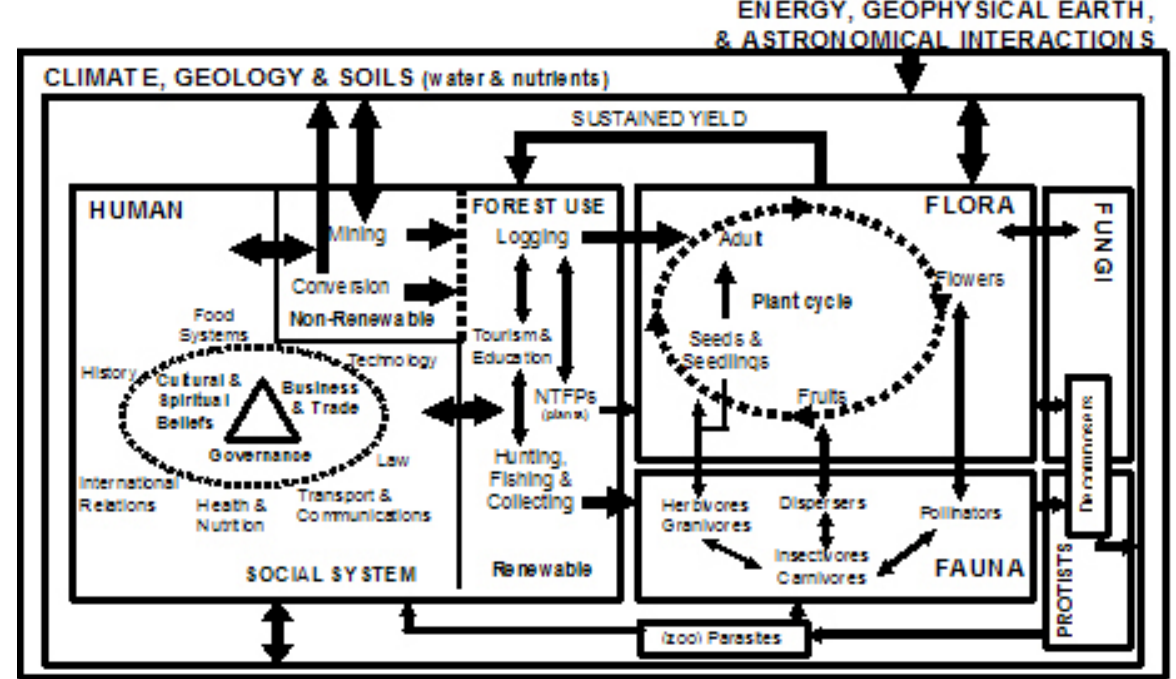
Fig. 1. Schematic depicting basic interrelationships between physical, biological, social, economic, and cultural systems that operate to influence forest management at different scales. Arrowhead size indicates relative measure of influence on